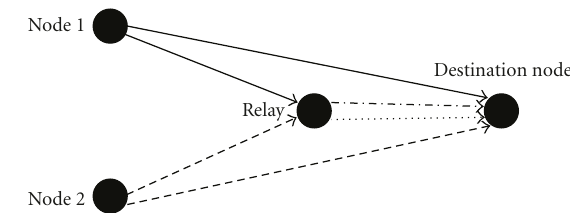
Figure 1: A simple multiple access relay channel with two source